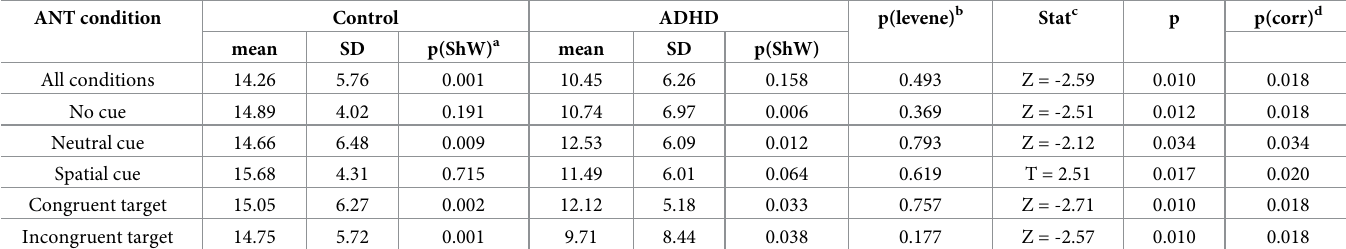
Table 3. Comparisons of maximum P3 peak amplitude ( μ V) in the Pz channel between groups in all ANT cue and target conditions and the mean value of all conditions. ANT